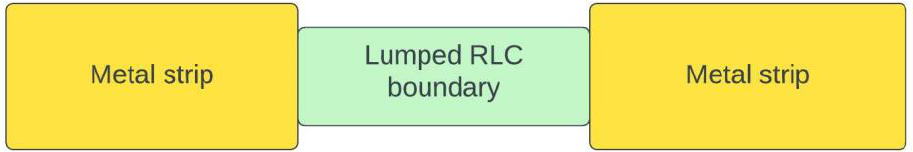
Figure 19. PIN diode model and its Equivalent circuits for ON and OFF